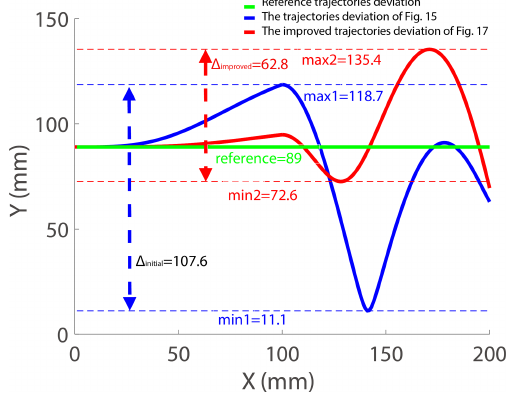
Figure 18. Comparison of trajectories deviations.